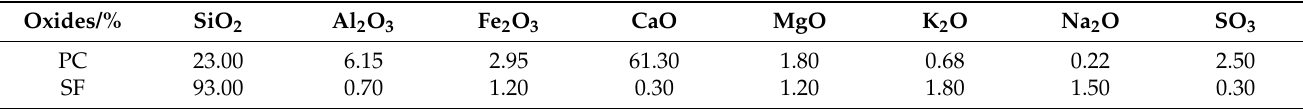
Table 1. Chemical composition of Portland cement and silica